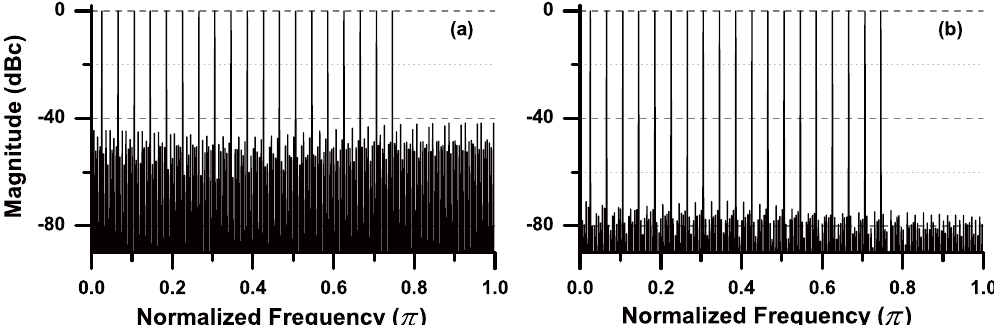
Figure 9. The spectra of 8-TIADC ( a ) before and ( b ) after